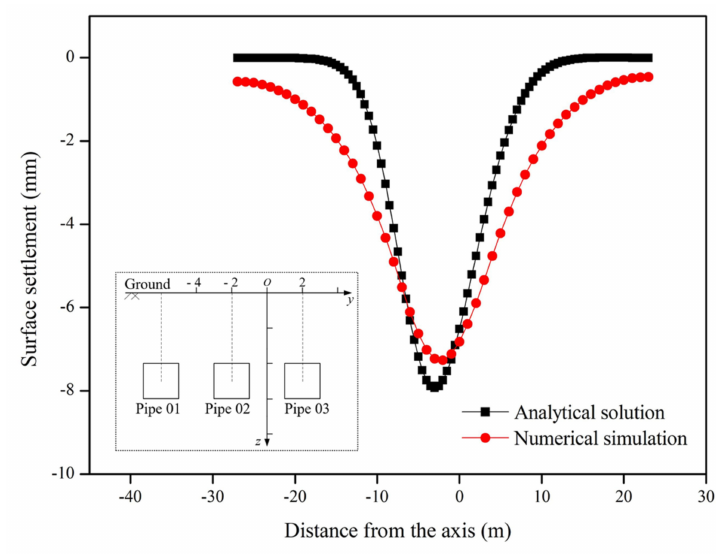
Figure 10. Curves of transverse ground surface settlement.